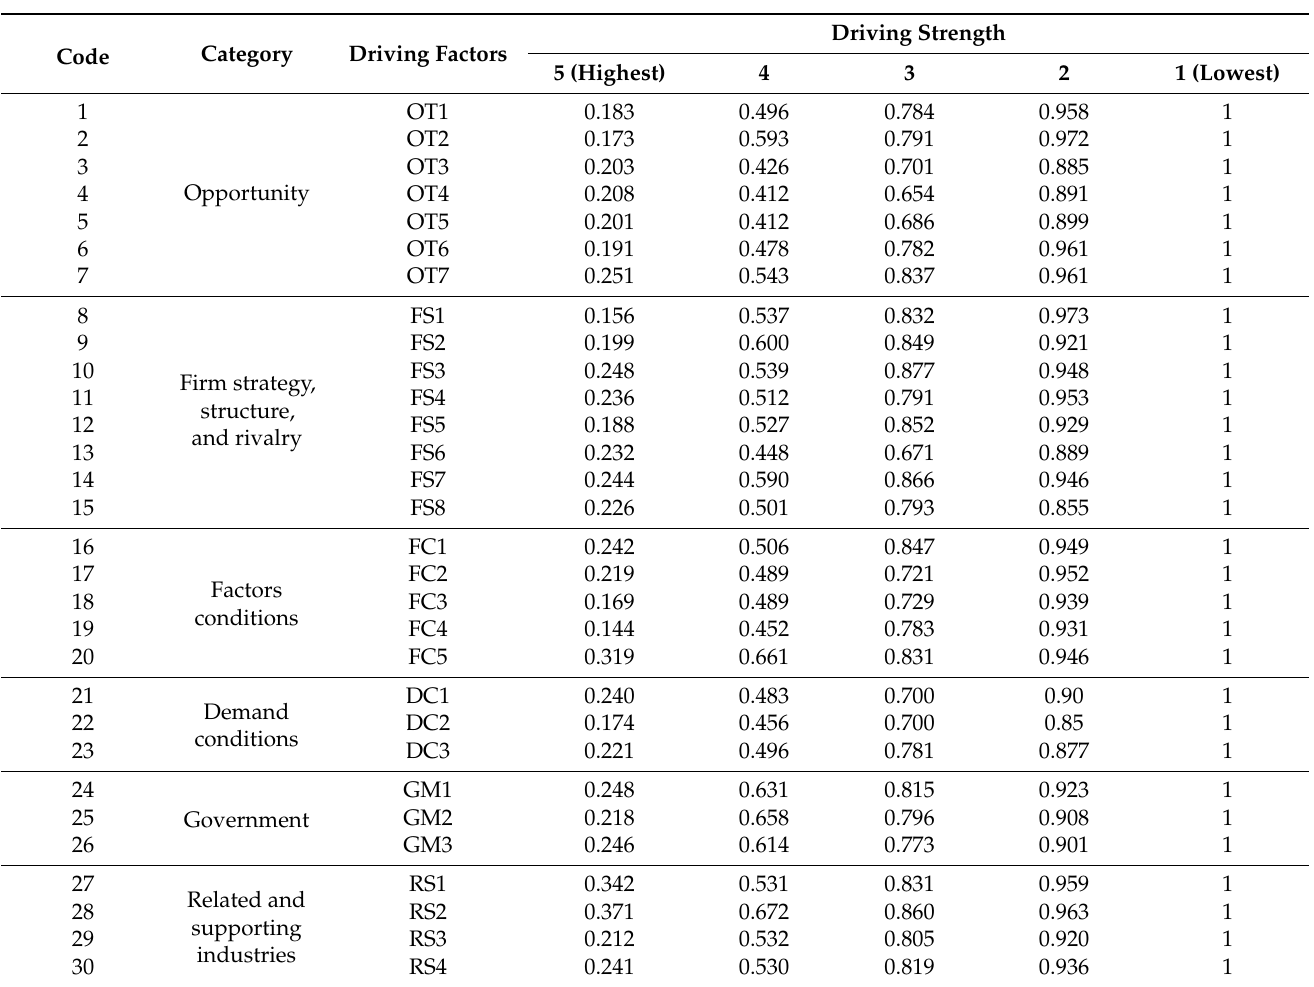
Table 5. Driving effects of the driving factors for IC